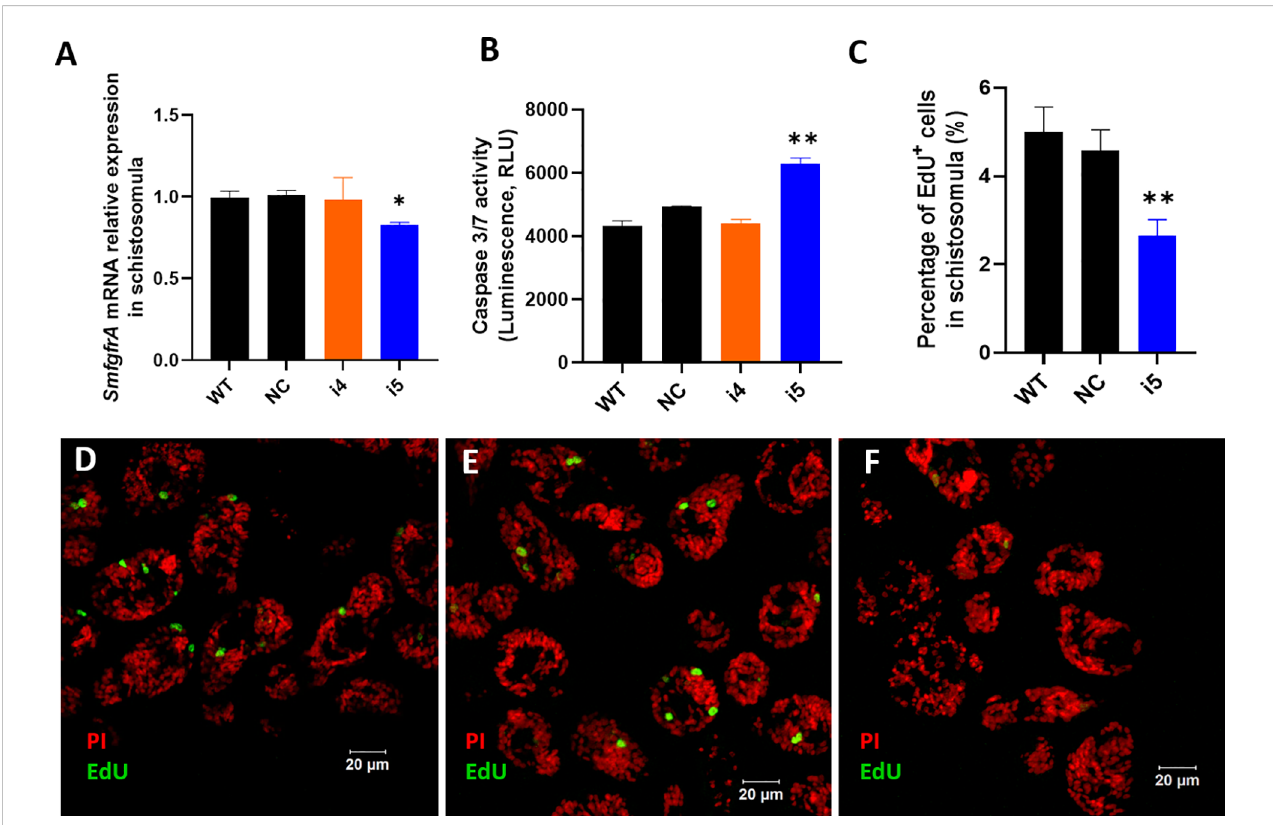
FIGURE 3 CRISPRi-mediated SmfgfrA repression in S. mansoni schistosomula. (A) SmfgfrA transcription level in untreated WT schistosomula and schistosomula treated with NC, i4 or i5. (B) Effect of SmfgfrA- repression on caspase-3/-7 activity in i4-treated or i5-treated schistosomula. WT schistosomula and schistosomula treated with NC were used as controls. Experiments in panels (A, B) was performed in duplicate with data presented as the mean ± SE. (C) The percentage of EdU + cell nuclei in WT schistosomula and schistosomula treated with NC, i4 or i5. All data are demonstrated as the mean ± SE (WT: n=33; NC: n=42; i5: n=42). Confocal projections representing EdU (green) and PI (red) labeled (D) WT schistosomula, (E) NC-treated schistosomula and (F) i5-treated schistosomula. * p value ≤ 0.05, ** p value ≤